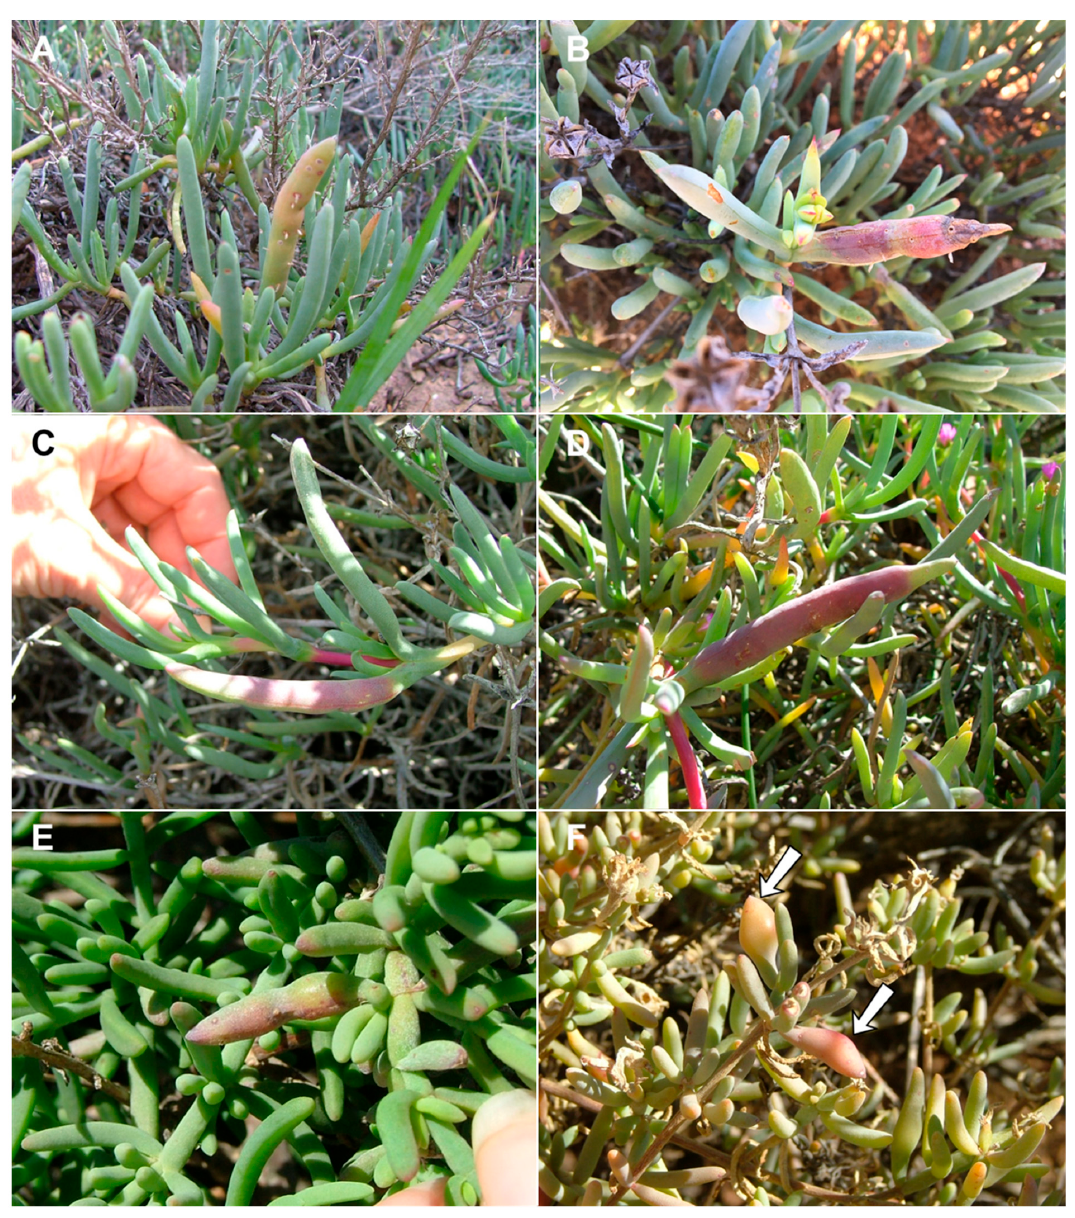
Figure 6. Ruschiola galls. ( A , B ). R. succulenta on Ruschia caroli . ( C , D ). R. succulenta on Lampranthus haworthii . ( E , F ). R. attenuata on Mesembryanthemum splendens . Arrows denote galled leaves. Adult description : Head, thorax and lateral parts of abdomen white; legs black; wing surface covered by dark hair-like setae, with thick black setae on C up to meeting point with R 4+5 . Abdominal tergites almost entirely black, except for thin transverse line of white scales along posterior margin. Abdominal pleura white, each with small black spot. Head (Figure 3B): Gap between eyes on vertex one to two facets wide. Antennal flagel- lomeres 11–15 in female ( n = 30), 10–12 in male ( n = 16), number often differs between antennae of same individual; cylindrical to barrel shaped, progressively shorter; two ad- jacent flagellomeres often fused; apical flagellomere slightly pointed or evenly rounded apically. Palpus two segmented; segment 1 globose or slightly longer than wide, setulose and bearing several long setae and scales; segment 2 usually subtending and partially